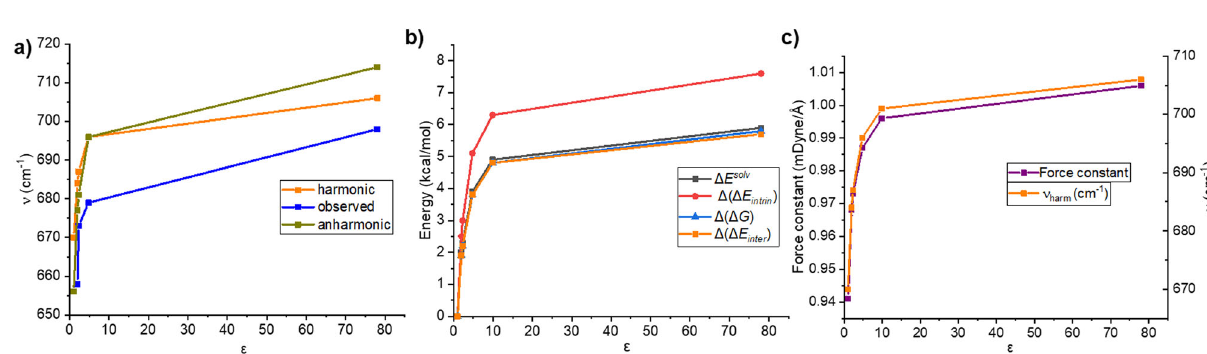
The deviation from the experiment ( Δ ν ) and assignment of B – N stretching with the potential energy distributions, PED% (C – N stretching in parenthesis) of the normal vibrational modes of Me 3 NBH 3 in various solvents. The values are calculated at the PBE0-D3/def2-QZVP level.